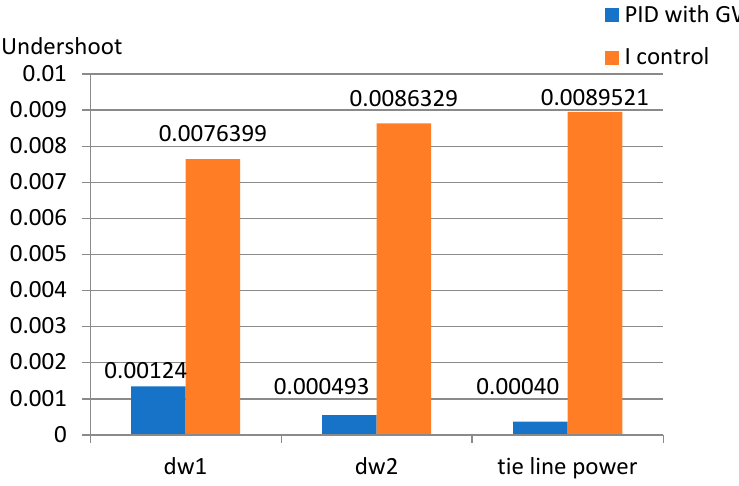
Figure 11. Overshoot variations in I and PID controllers.